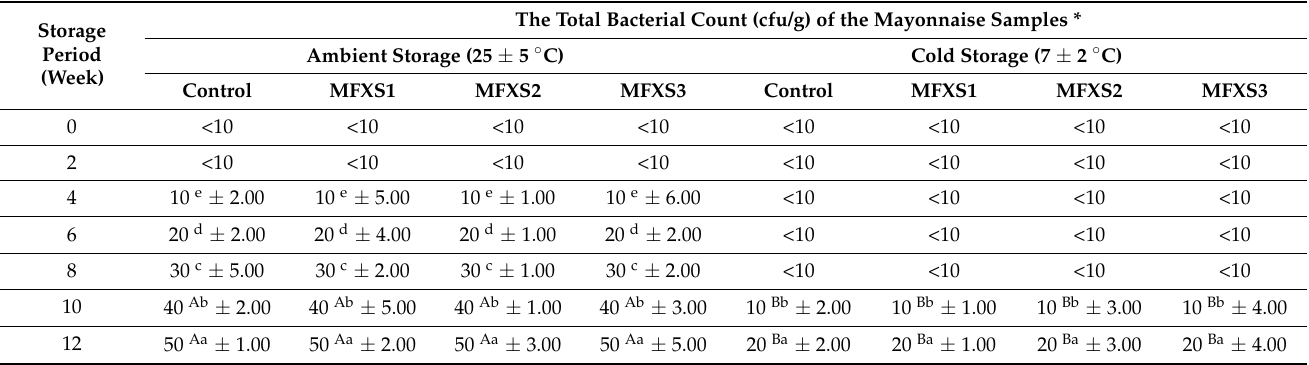
Table 3. The total bacterial counts (cfu/g) of mayonnaise samples during ambient and cold storage.